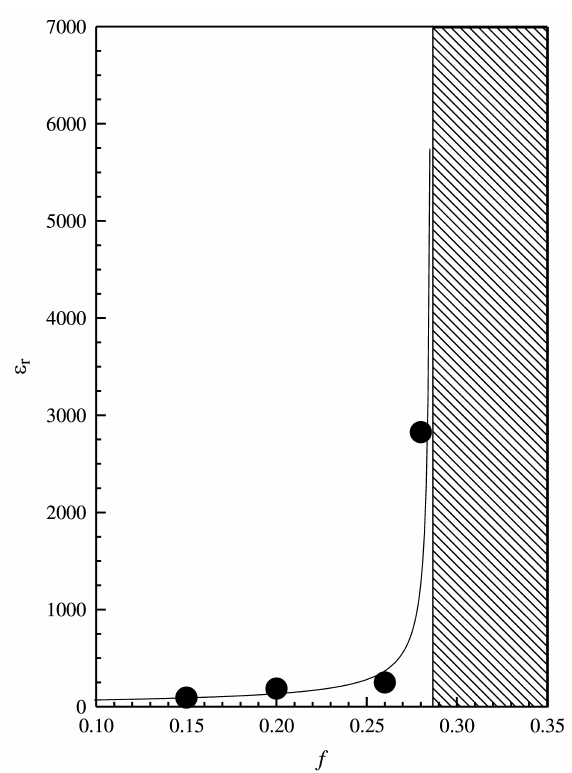
Figure 3. Relative dielectric constant( ε r ) vs. filling factor( f )correspond- ing to different monolithic ZrO 2 /stainless steelcomposites (15, 20, 26 and 28 vol.% metal).